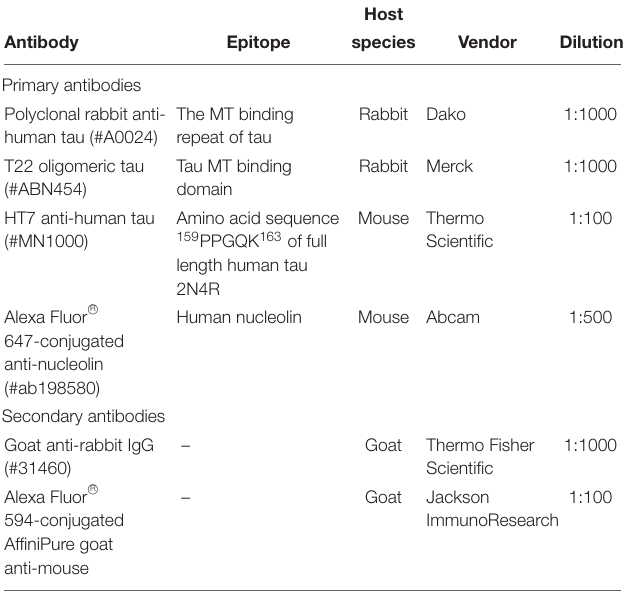
TABLE 1 | Antibodies used in this